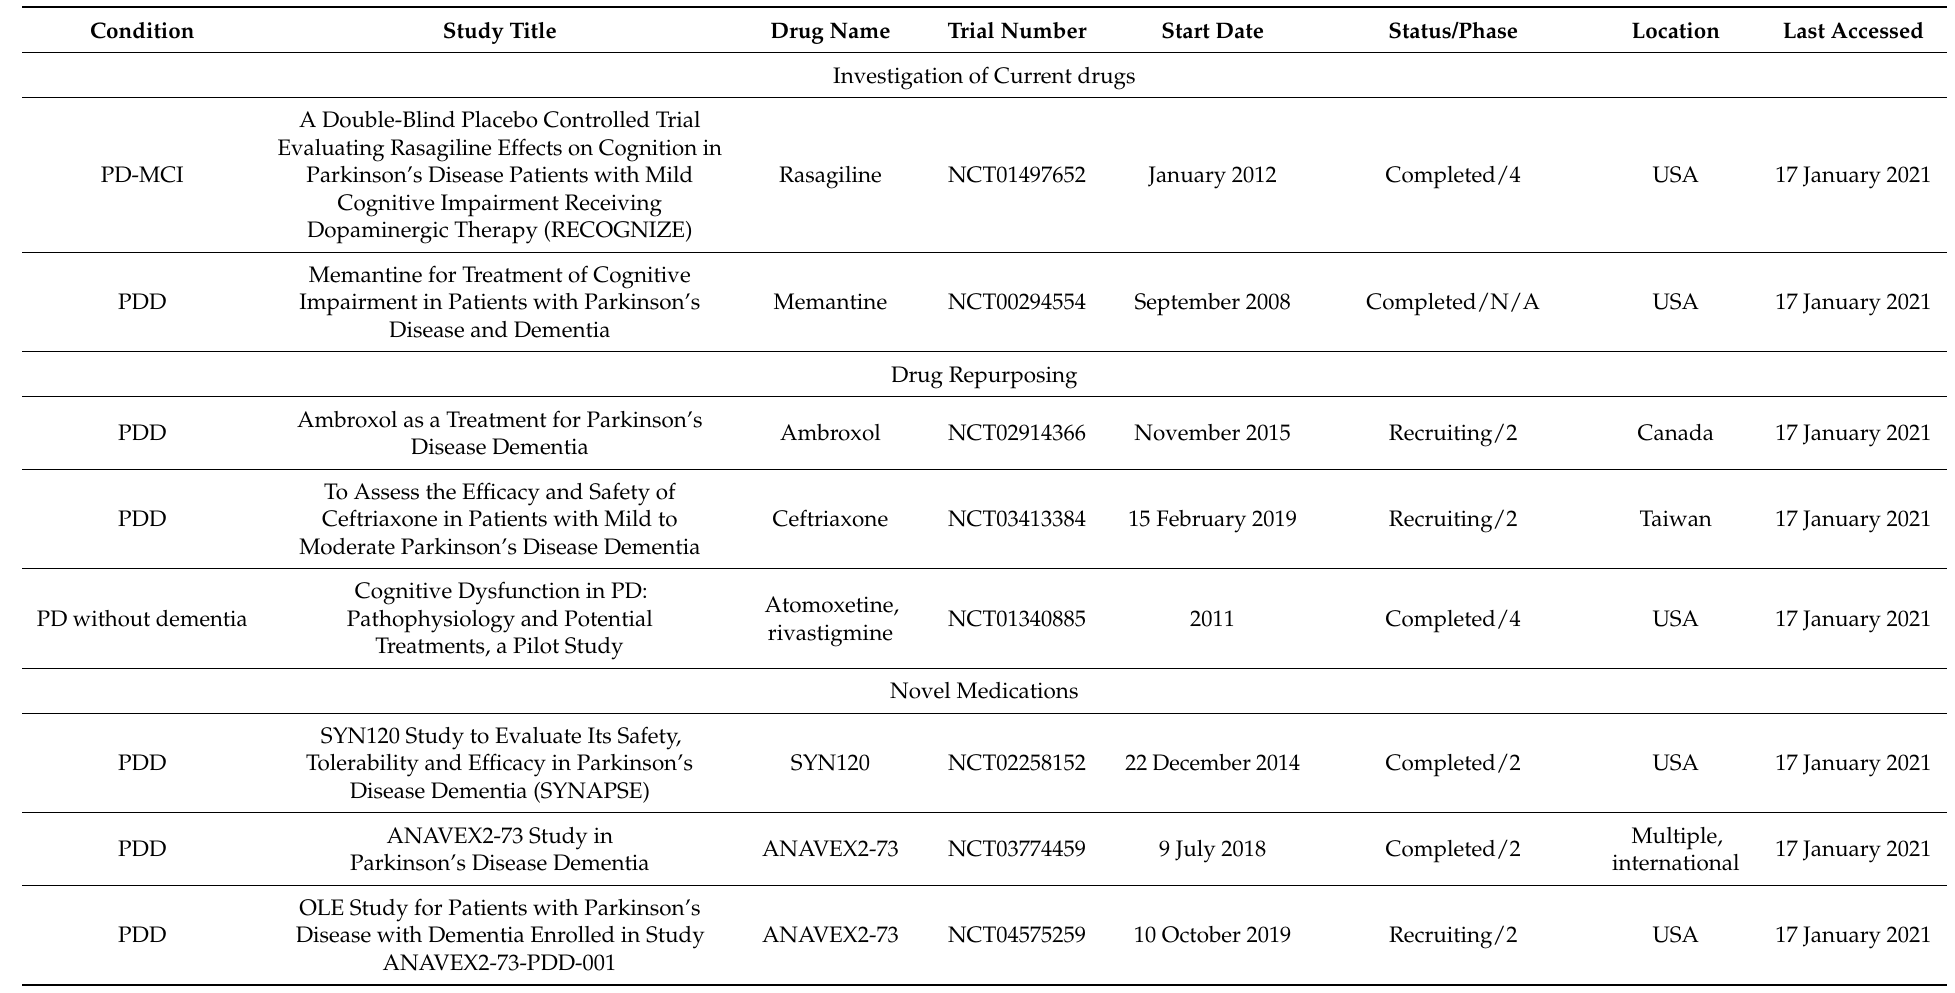
Table 4. Clinical trials on pharmacologic treatments for cognitive impairment in Parkinson’s